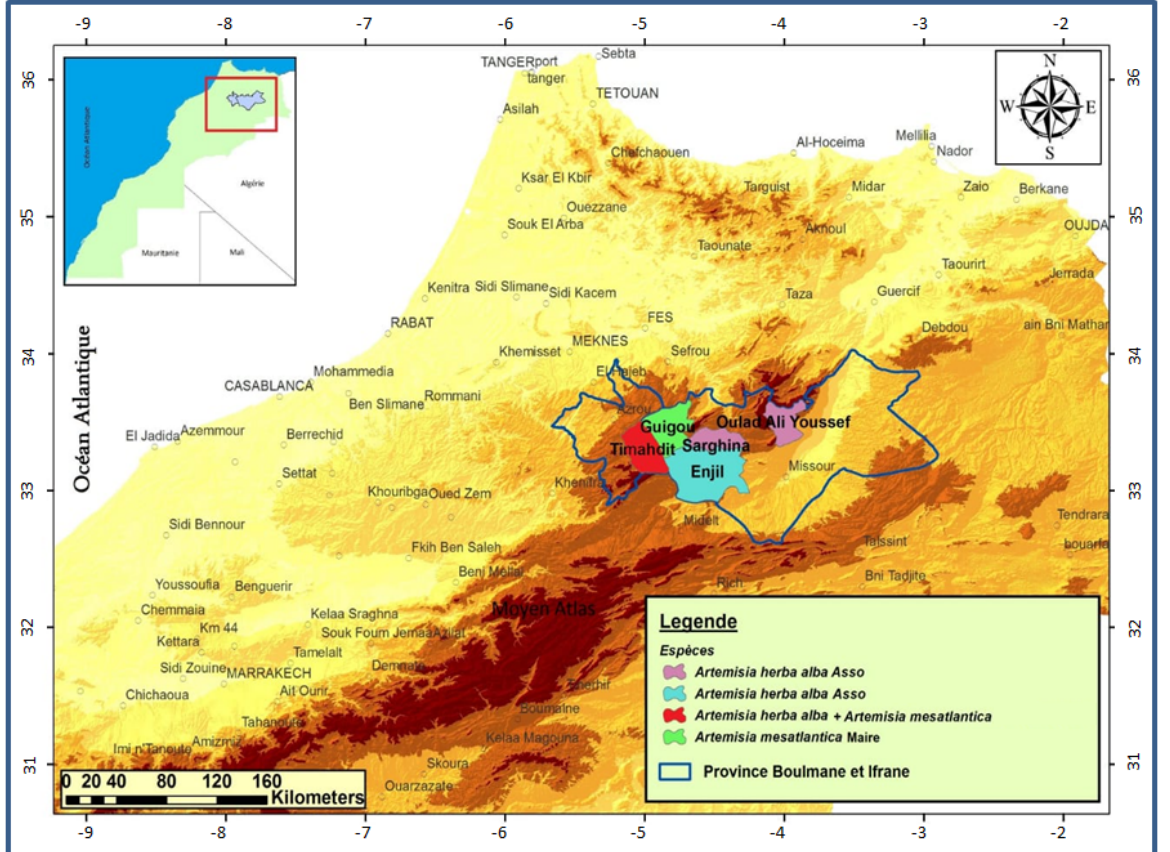
Figure 1. Map showing the harvesting sites of the two sagebrush species.